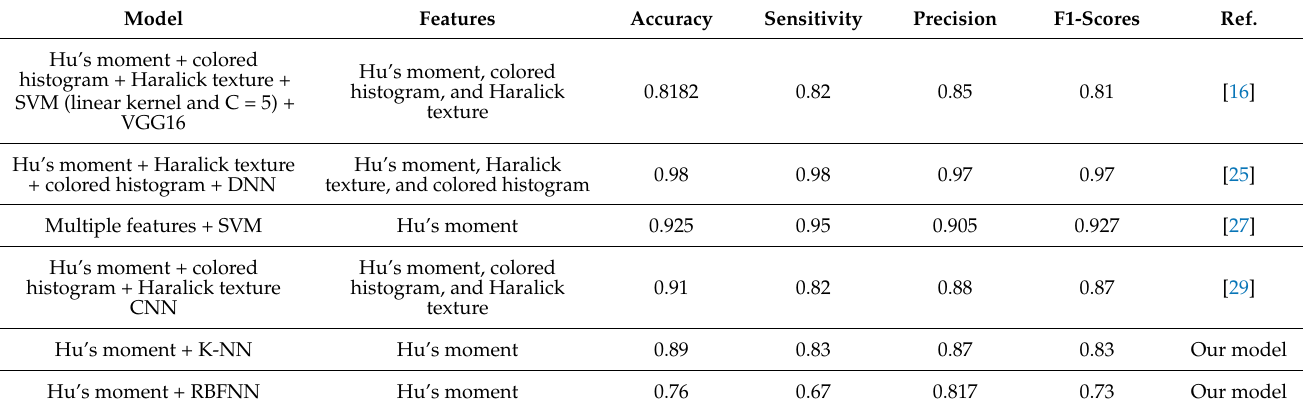
Table 2. Comparison of existing handcrafted approaches and the present handcrafted